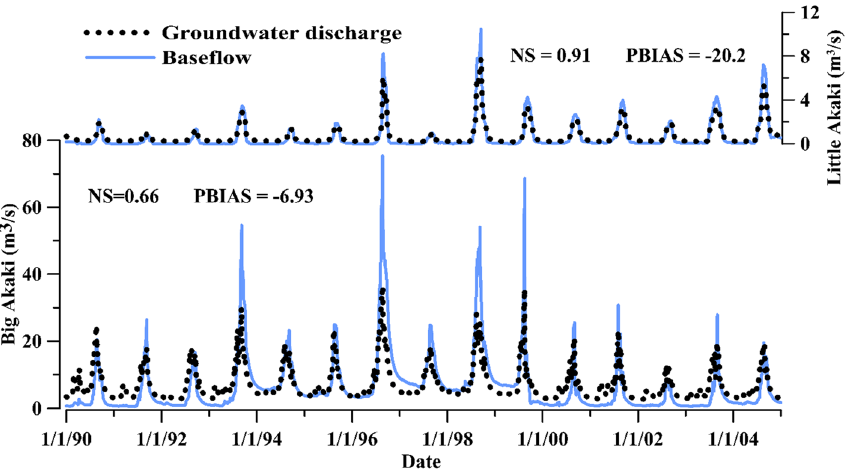
Figure 7. Comparison of SWAT-MODFLOW simulated groundwater discharge and baseflow in Little Akaki and Big Aaki Rivers.